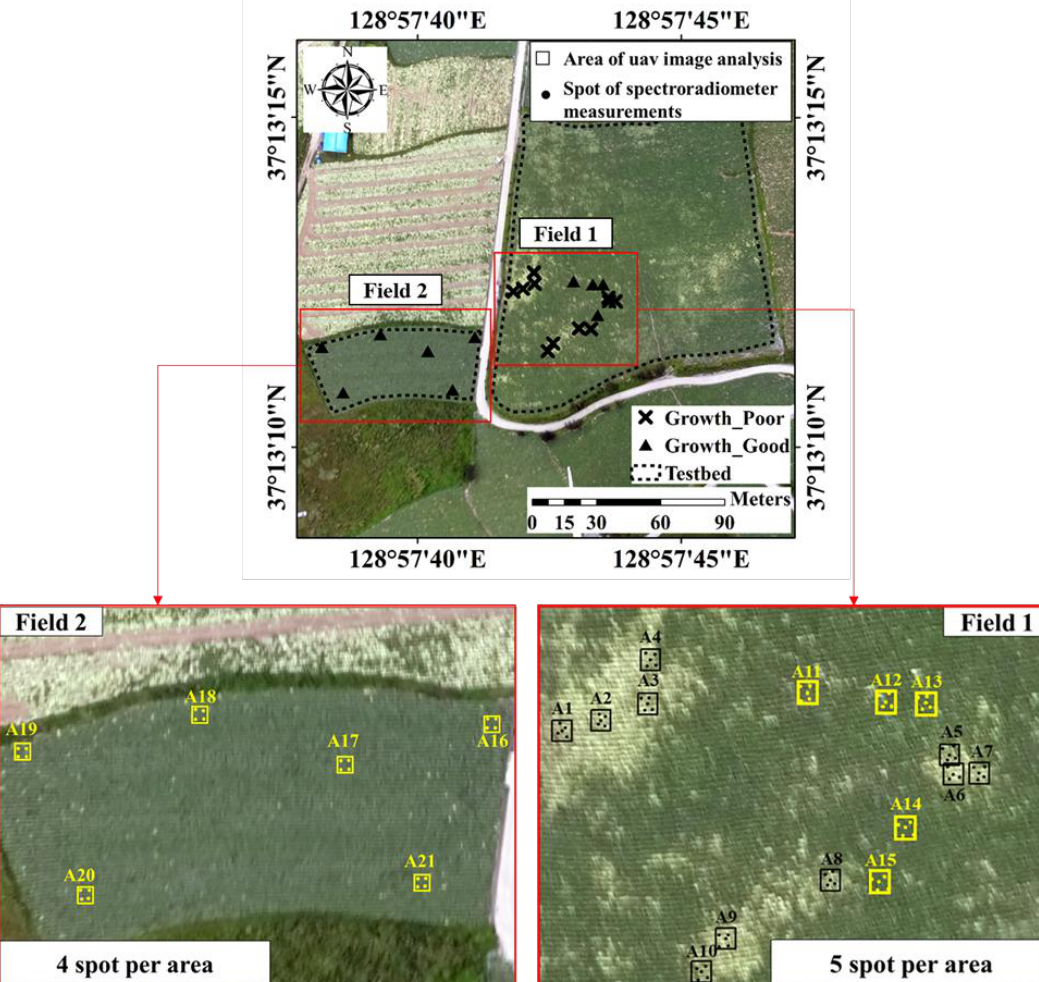
Figure 4. Selection of points for comparison and examination according to kimchi cabbage growth